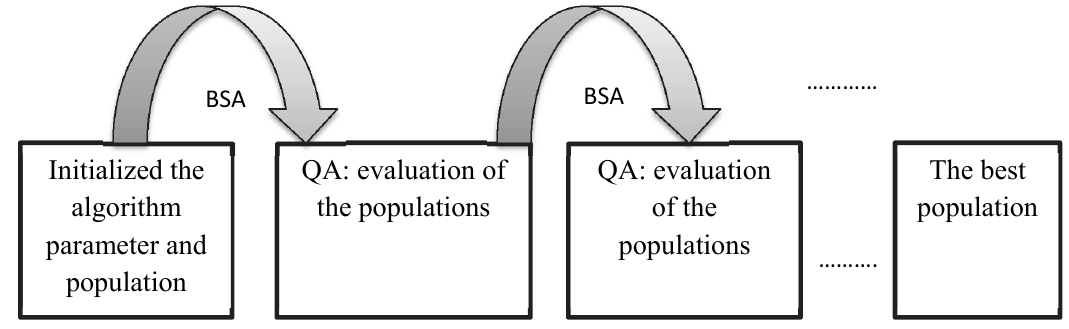
Fig.1. Diagram model of population’s